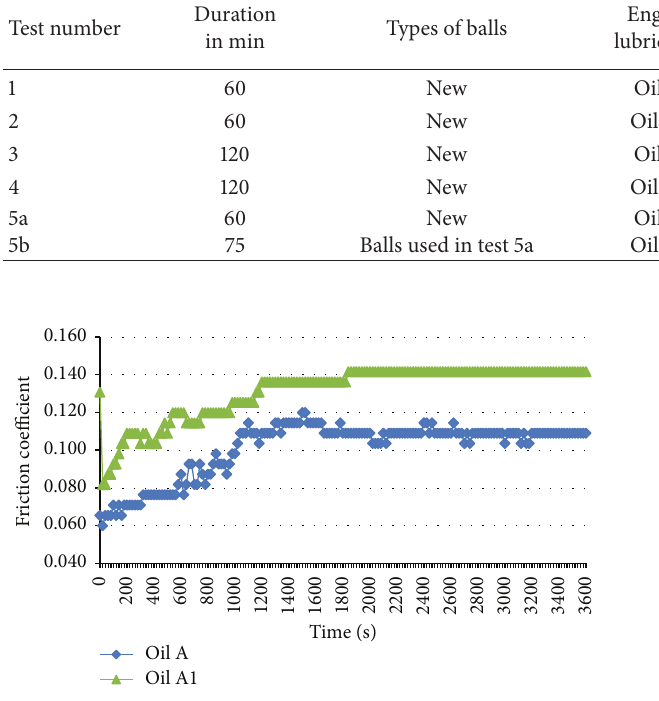
Figure 2: Friction coefficient variation with time using new balls (tests 1 and 2).